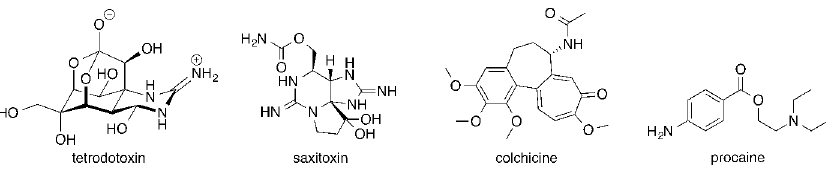
Figure 1. Chemical structures of alkaloids in a broad sense: natural alkaloids of non-plant origin, tetrodotoxin and saxitoxin; a natural but non-basic alkaloid, colchicine; and a synthetic alkaloid, procaine.